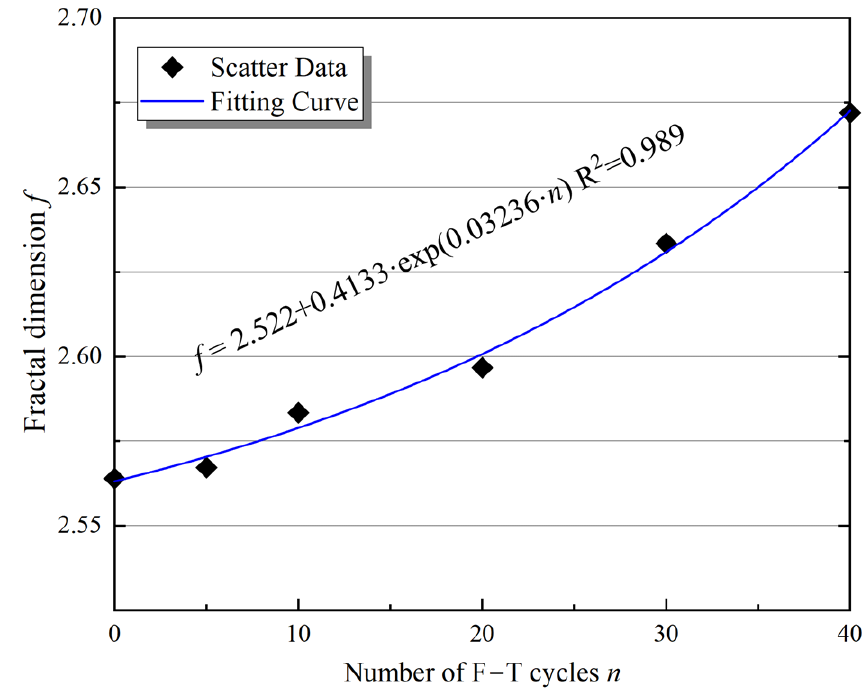
Figure 11. Variation of 3D fractal dimension of samples with different F–T cycles.